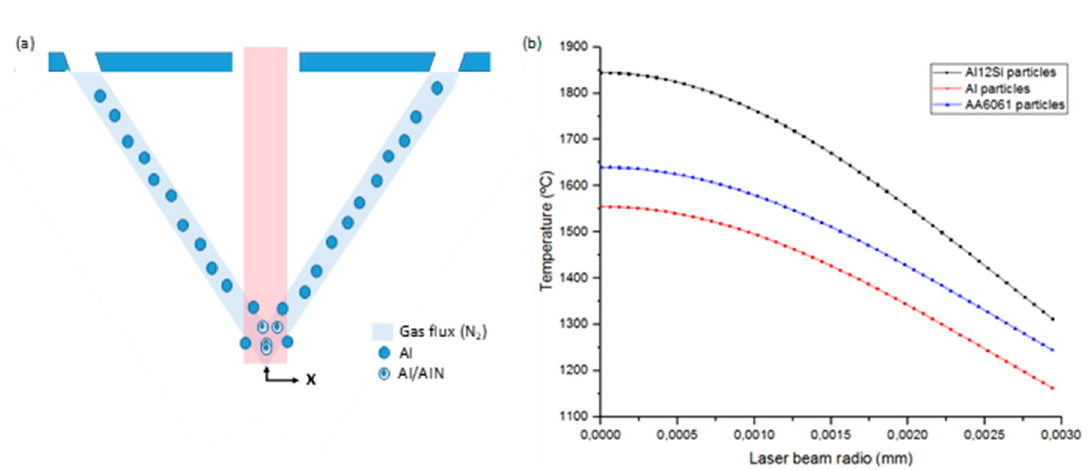
Figure 9. Temperature distribution for ( a ) diagram of the coaxial laser deposition nozzle used and the powder and gas flux ( b ) temperature distributions of the sprayed particles.